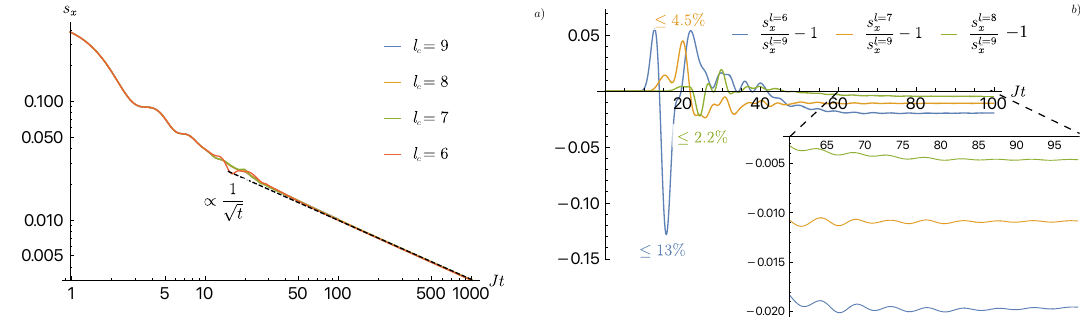
Figure 7: a) Expectation value of the spin on the central site n time for the initial state definied in Eq. (36) and for truncation values l 9. At late times, it follows the 1 /